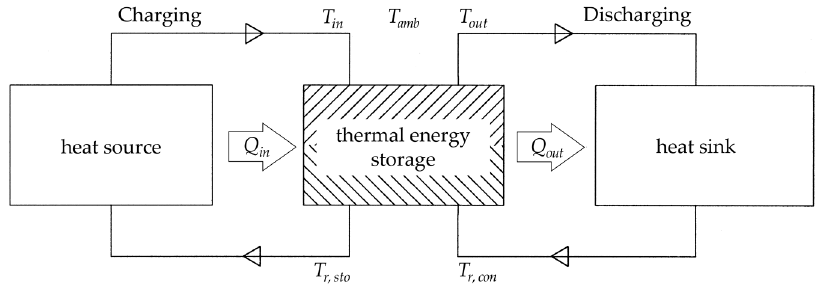
Figure 12. Temperature levels in a system with thermal energy storage.